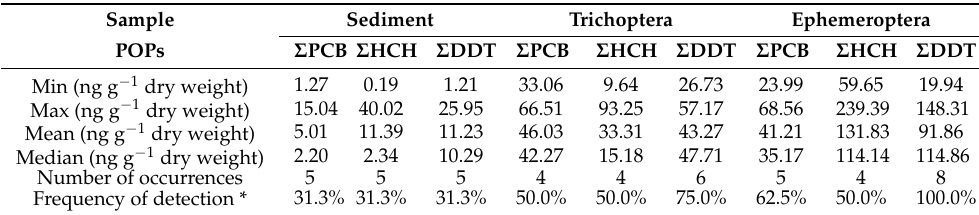
Table 1. Frequency of detection and concentration range of Σ PCB, Σ HCH, and Σ